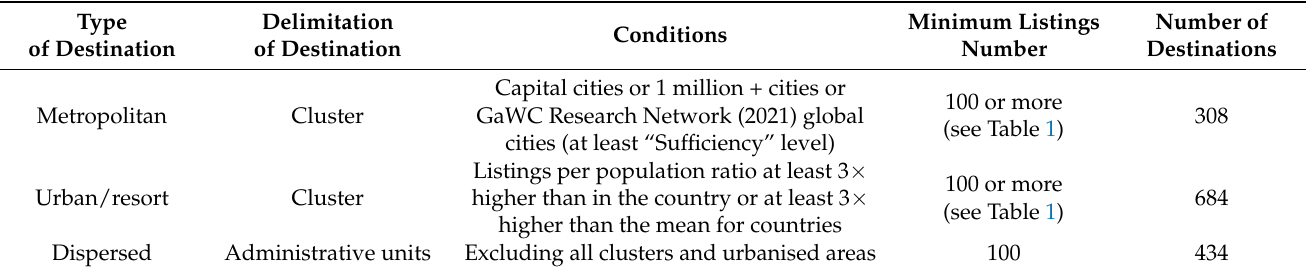
Table 2. Criteria for delimiting destinations based on valid Airbnb